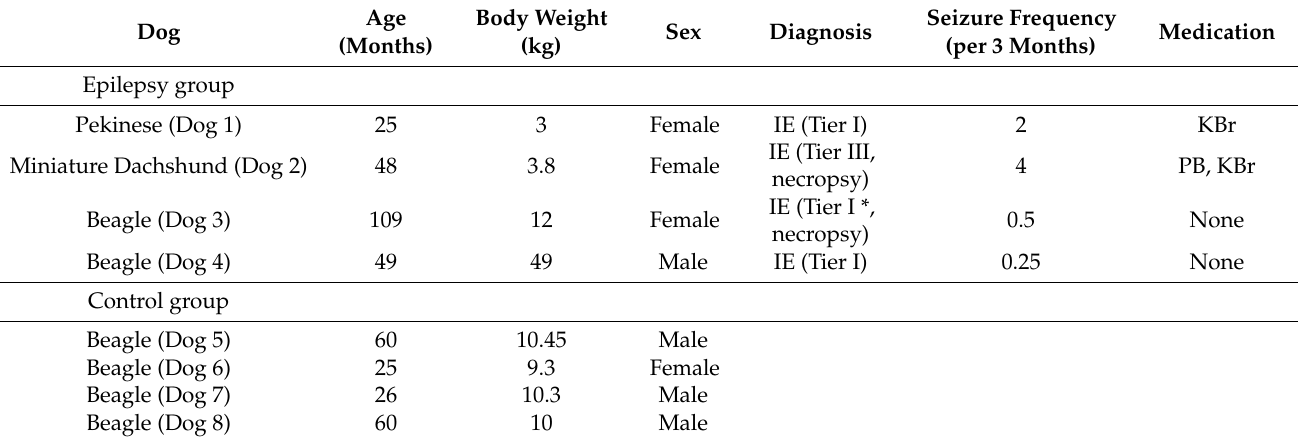
Table 1. Seizure type, clinical seizure signs (semiology), and the laterality of seizure signs in each dog are shown in Table 2. Table 1. Information on dogs.